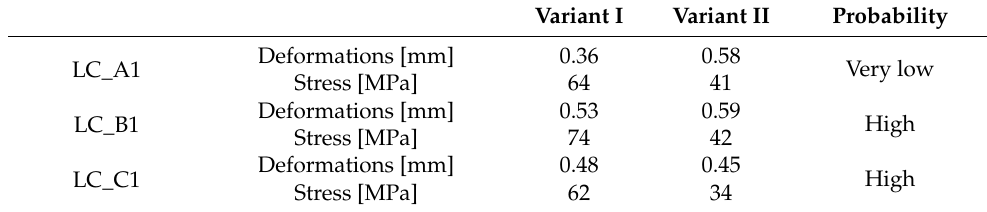
Table 3. Comparative table of flexibility of both variants under